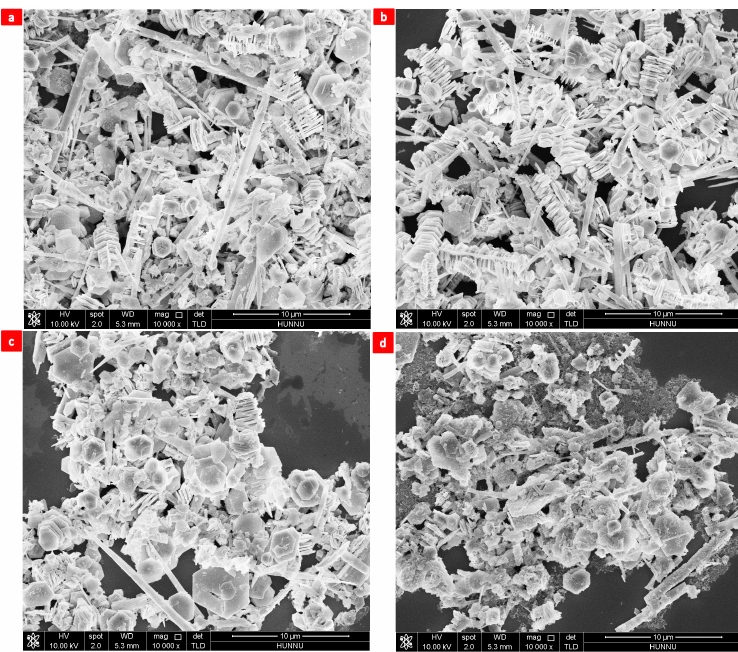
Figure 5. A series of the surfactants ( a ) no surfactant, ( b ) CTAB, ( c ) EDTA, ( d ) SDBS. Table 3. A series of the surfactants influenced on the morpholoy of Bi 2 Te 3